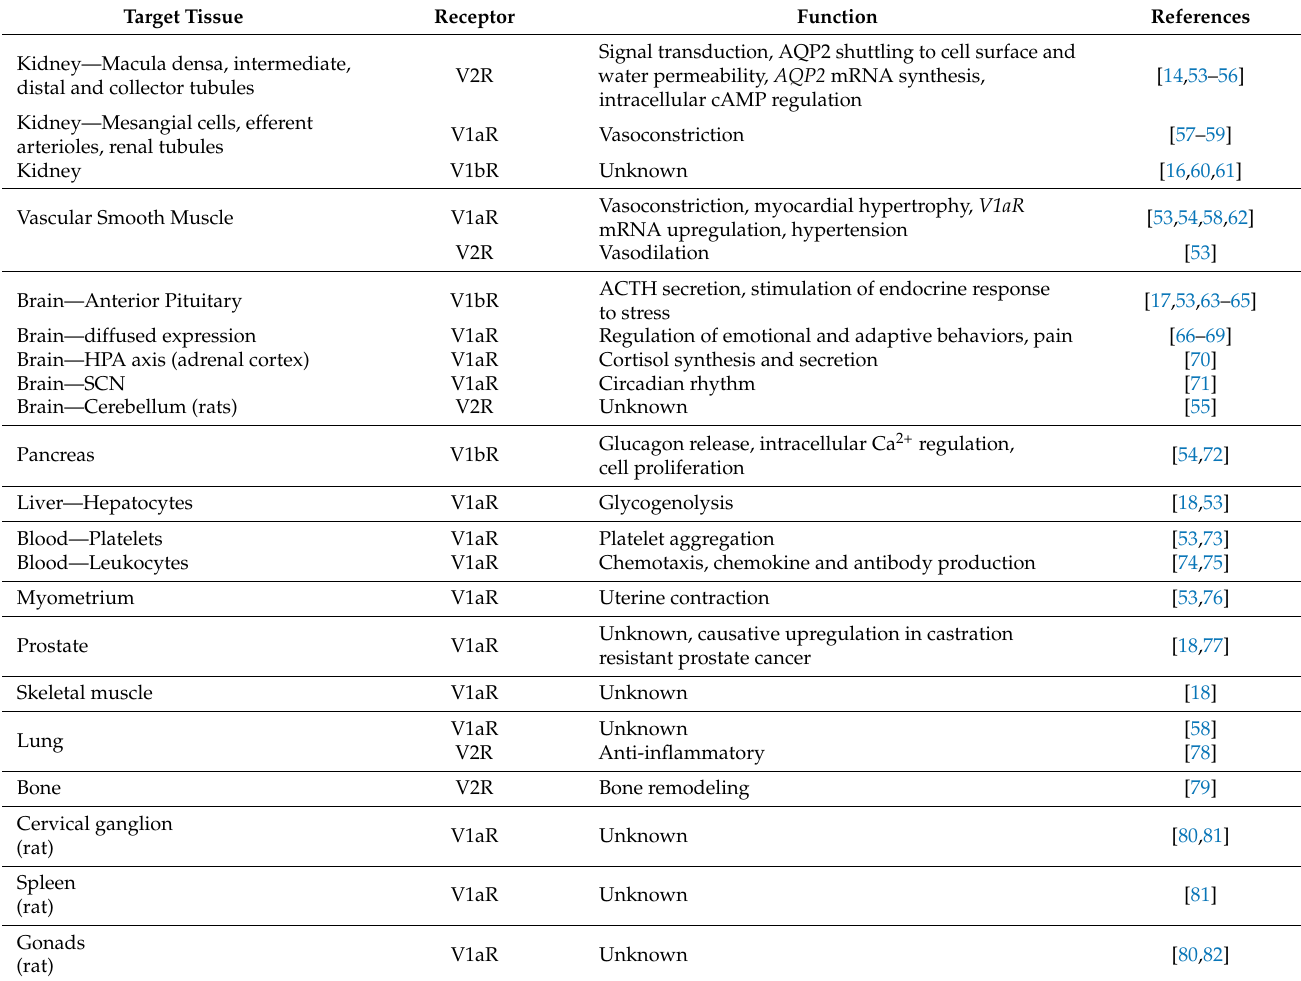
Table 1. AVP receptor function and